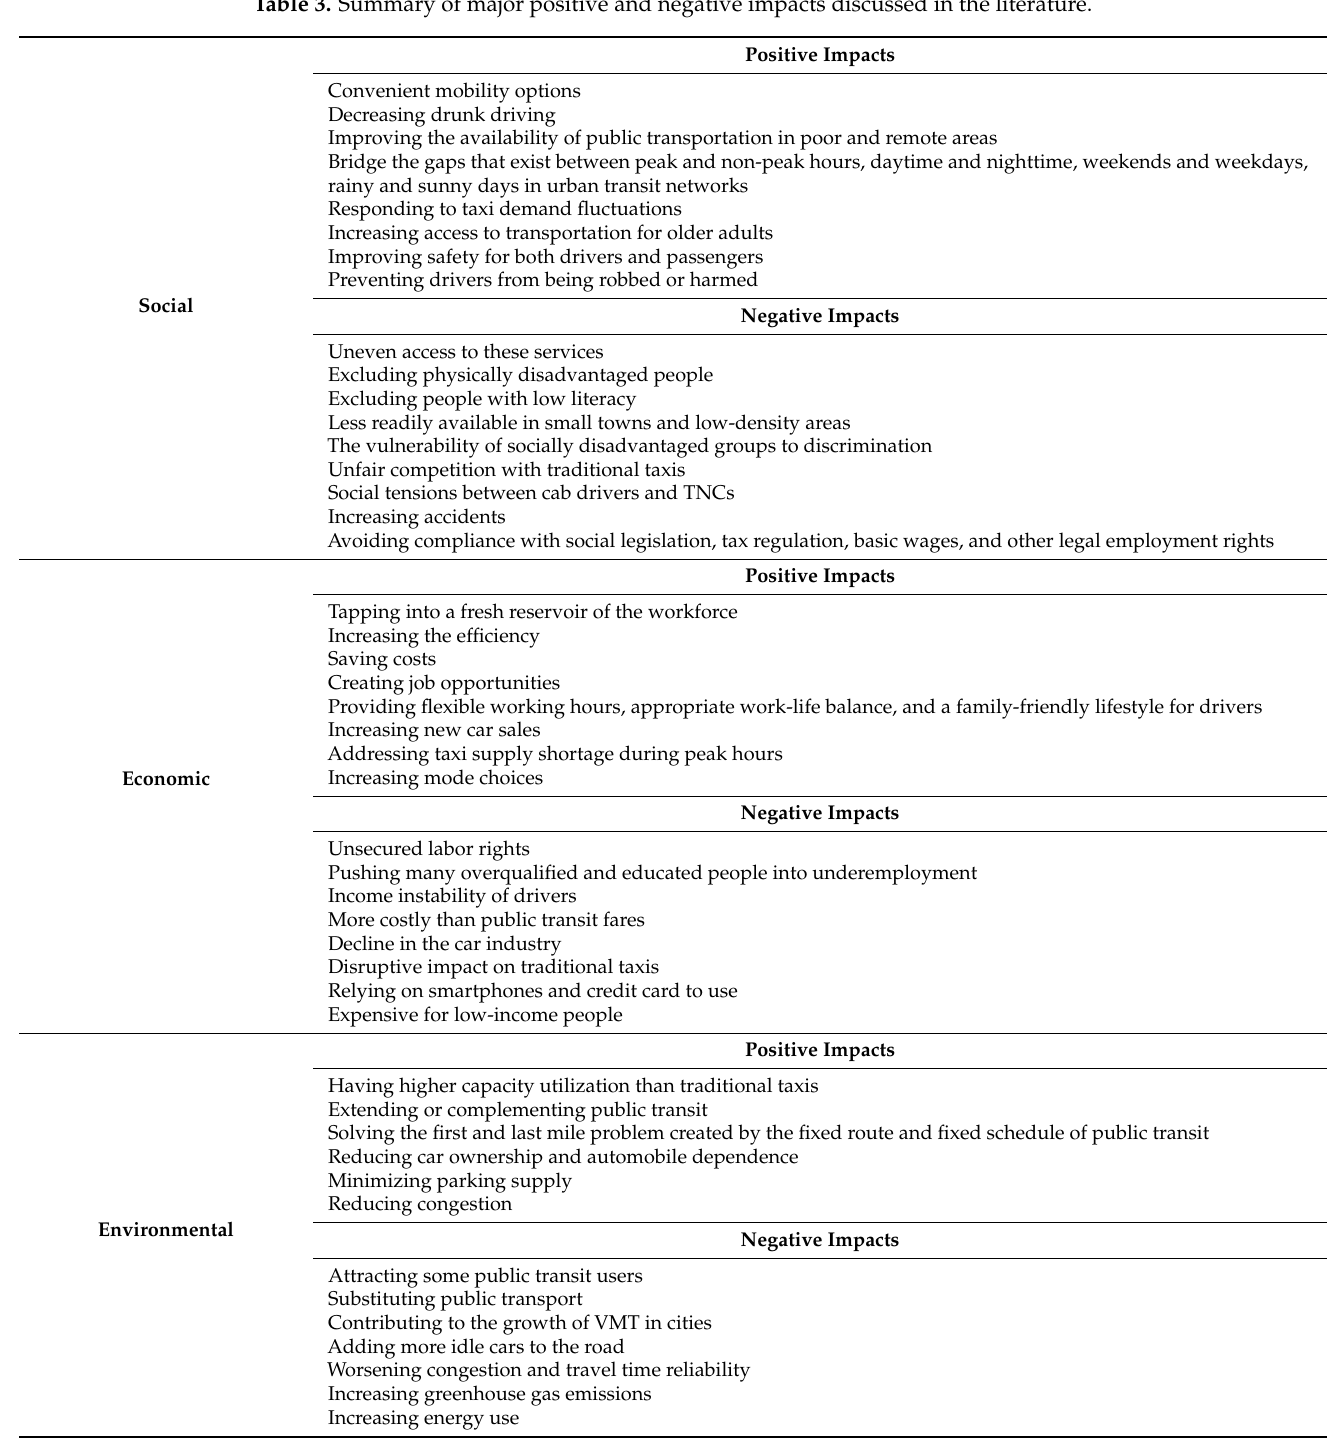
Table 3. Summary of major positive and negative impacts discussed in the